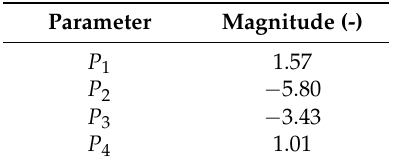
Table 3. Filter function parameters